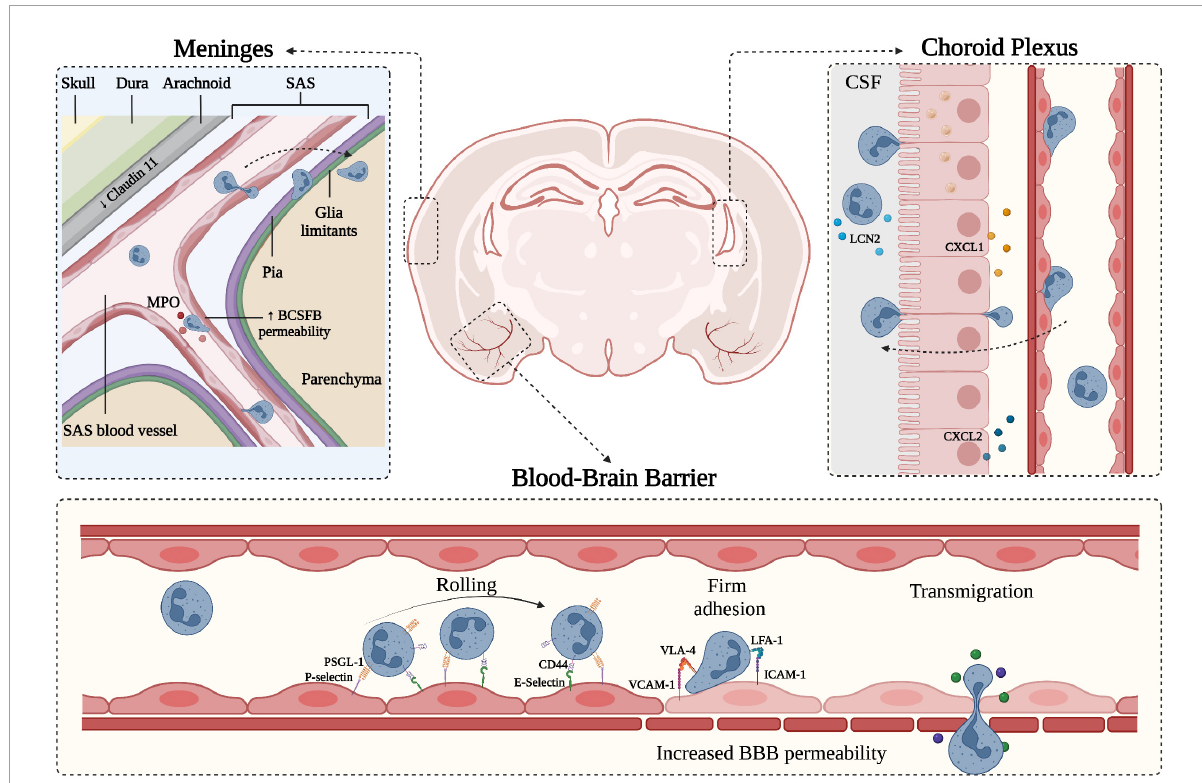
FIGURE1 Schematic representation of neutrophil migration through the CNS barriers. CNS barriers limit the accessibility of circulating cells and molecules and can be divided into two main components: the Blood-Brain-Barrier (BBB) situated within the brain parenchyma and the blood-CSF-barrier (BCSFB) present in the choroid plexus (ChP) and in the meninges. Starting from the outer part of the CNS (depicted on the top left), the meninges represent a series of connective layers surrounding the brain, including dura mater and leptomeninges (arachnoid and pia mater). During CNS inflammatory diseases, neutrophils adhere in pial vessels and migrate into the SAS; these cells may then cross pia matter and migrate into the underlying brain parenchyma. Within the leptomeningeal vessels, neutrophils release MPO, potentially damaging endothelial cells and the extracellular matrix. On the top right, a representation of the choroid plexus shows the production of neutrophil chemoattractants CXCL1 and CXCL2 by the epithelial cells leading to neutrophil infiltration across the BCSFB. In both ChP stroma and within the CSF, neutrophils have been shown to produce LCN2. On the lower panel, a simplified model of the BBB is depicted, along with the classical neutrophil migration cascade. Inflamed BBB endothelial cells express adhesion molecules such as P- and E-selectins mediating capture and rolling through interaction with neutrophil PSGL-1 and CD44. Endothelial ICAM-1 and VCAM-1 mediate the arrest phase by binding neutrophil integrins LFA-1 and VLA-4, respectively. Firm adhesion and transmigration may contribute to increased BBB permeability (created with